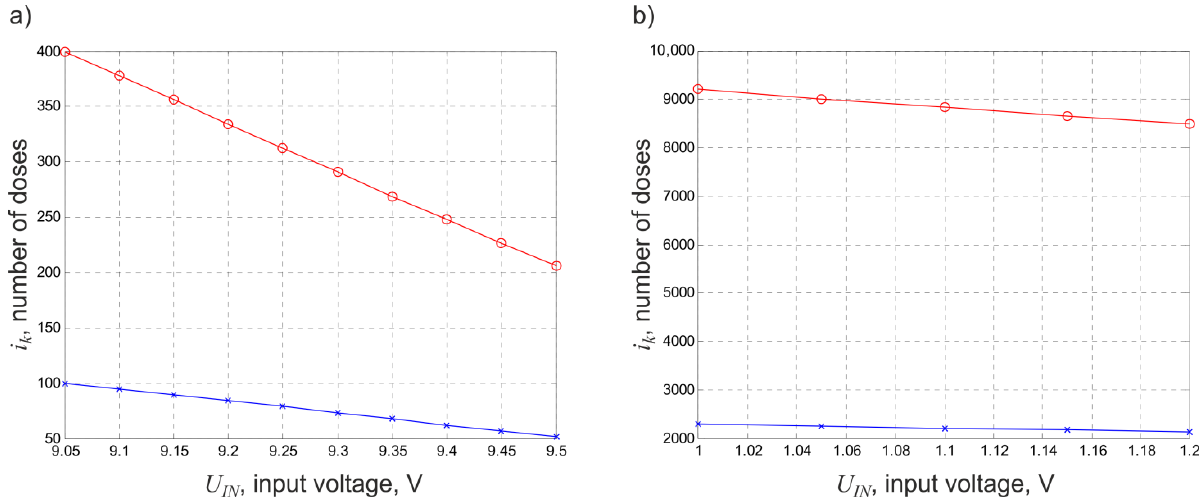
Figure 7. Processing time diagrams of the multifunction ADCF converter for 10 input voltages and set errors of 0.1% (blue x) and 0.025% (red o): ( a ) for the upper part of the operating range; ( b ) for the lower part of the operating